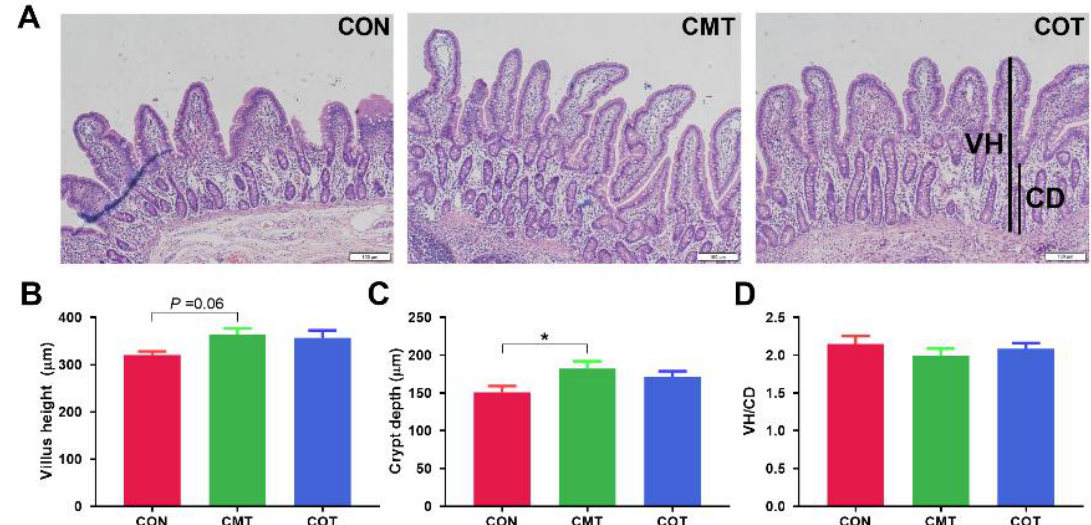
Figure 3. Histological and morphometrical analyses of ileum. ( A ) Hematoxylin and eosin staining of ileum tissue. ( B ) Villus height. ( C ) Crypt depth. ( D ) The ratio of VH/CD. 100 × magnification; Scale bars, 100 µ m. Star (*) indicates that there are significantly different (at the 5% threshold of the ANOVA) between groups.